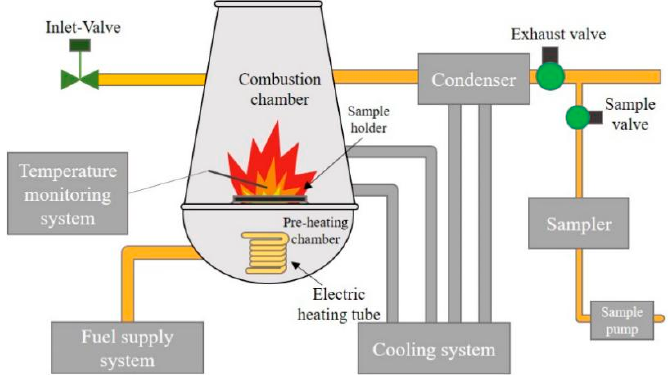
Figure 1. High-temperature experiment apparatus. Table 2. The mass median diameter (MMD) of the impactor.